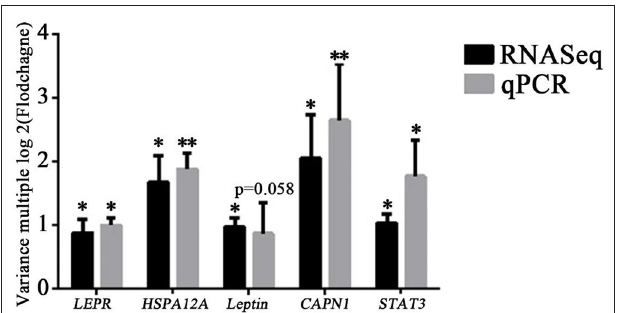
FIGURE 5 | Verification of differentially expressed genes by qPCR. Data were presented as means ± SD of at least three independent